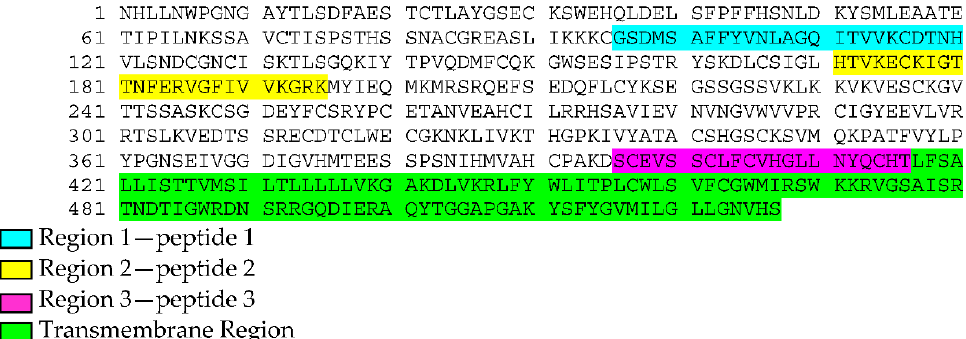
Figure 1. Three aminoacid sequences identified by pepscan analysis.